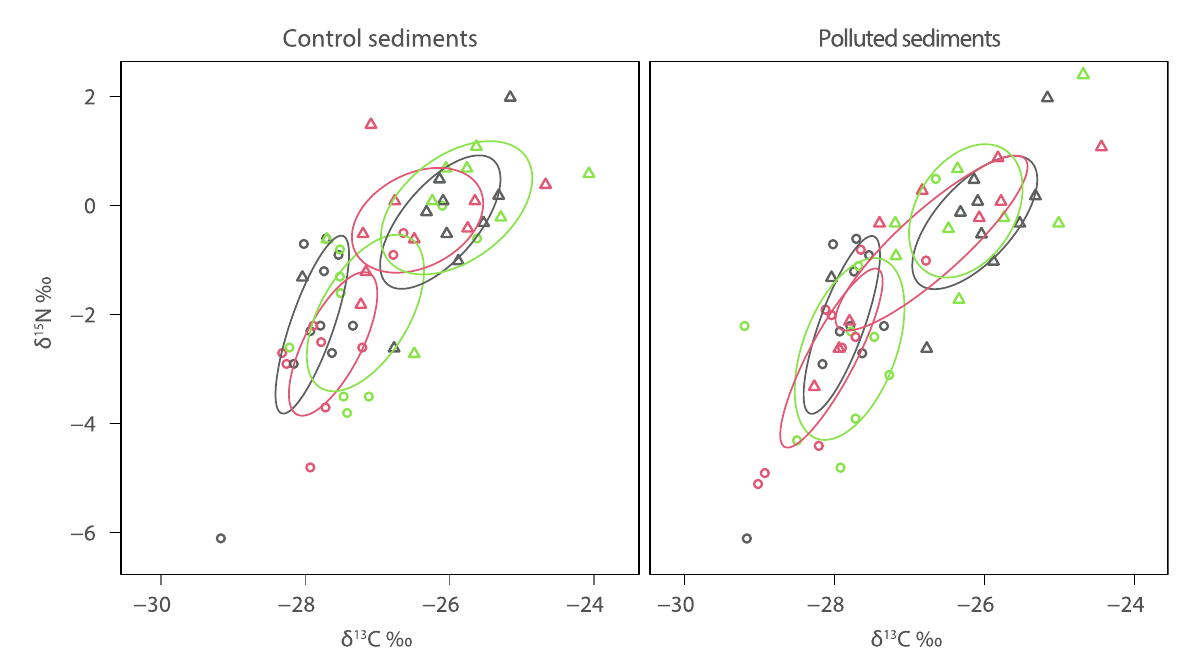
FIGURE 5 Isotopic niche of lucinid tissues exposed to the different experimental conditions. The lines enclose the Bayesian standard ellipse area (SEA B ). Initial (T0) samples are represented in grey, samples from the L treatment are in red, while those from the PL treatment are shown in green. Triangles are used for symbiont-free (rest) and circles for symbiont-hosting (gill) lucinid clam tissues. See Supplementary Figure S6 for the density plot of SEA B